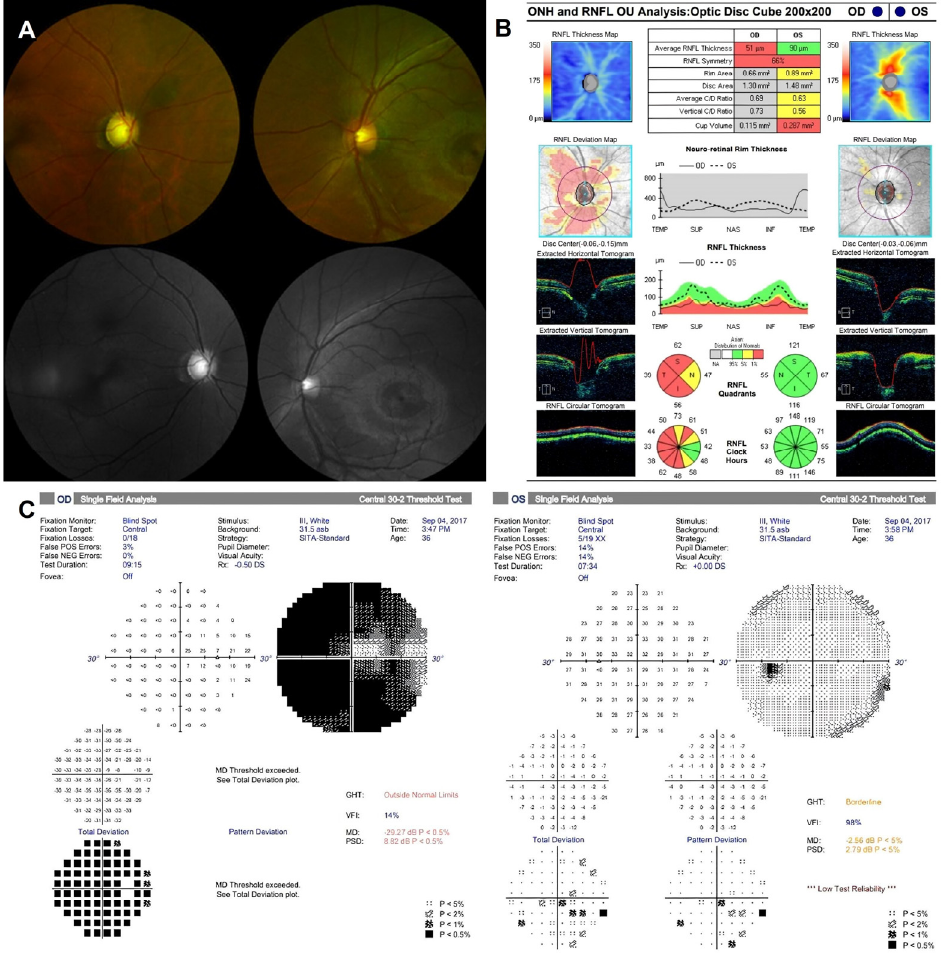
Figure 2. Ophthalmic images of the patient at the initial visit. ( A ) Fundus photography showed glaucomatous cupping of optic nerve head (ONH) in the right eye and normal ONH in the left eye. ( B ) Optical coherence tomography showed the thinning of retinal nerve fiber layer (RNFL) in all four quadrants of the right eye and the normal range of RNFL in the left eye. ( C ) Humphrey 30-2 visual field revealed of visual field narrowing in the right eye compared to the left